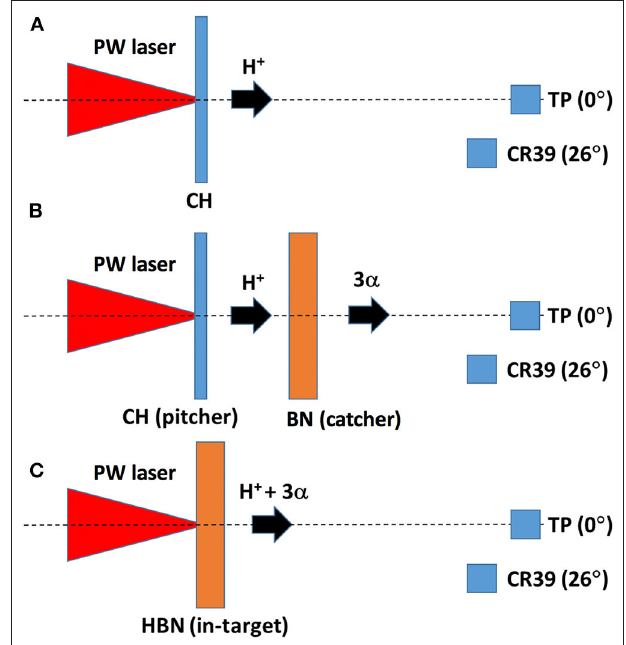
FIGURE 1 | A sketch of the experimental geometries investigated in our experiment: (A) study of proton generation from plastic target (B) in-target pB reaction, and (C) beam-target pB reaction. Also shown the angular position of Thomson Parabola and CR 39 detector.